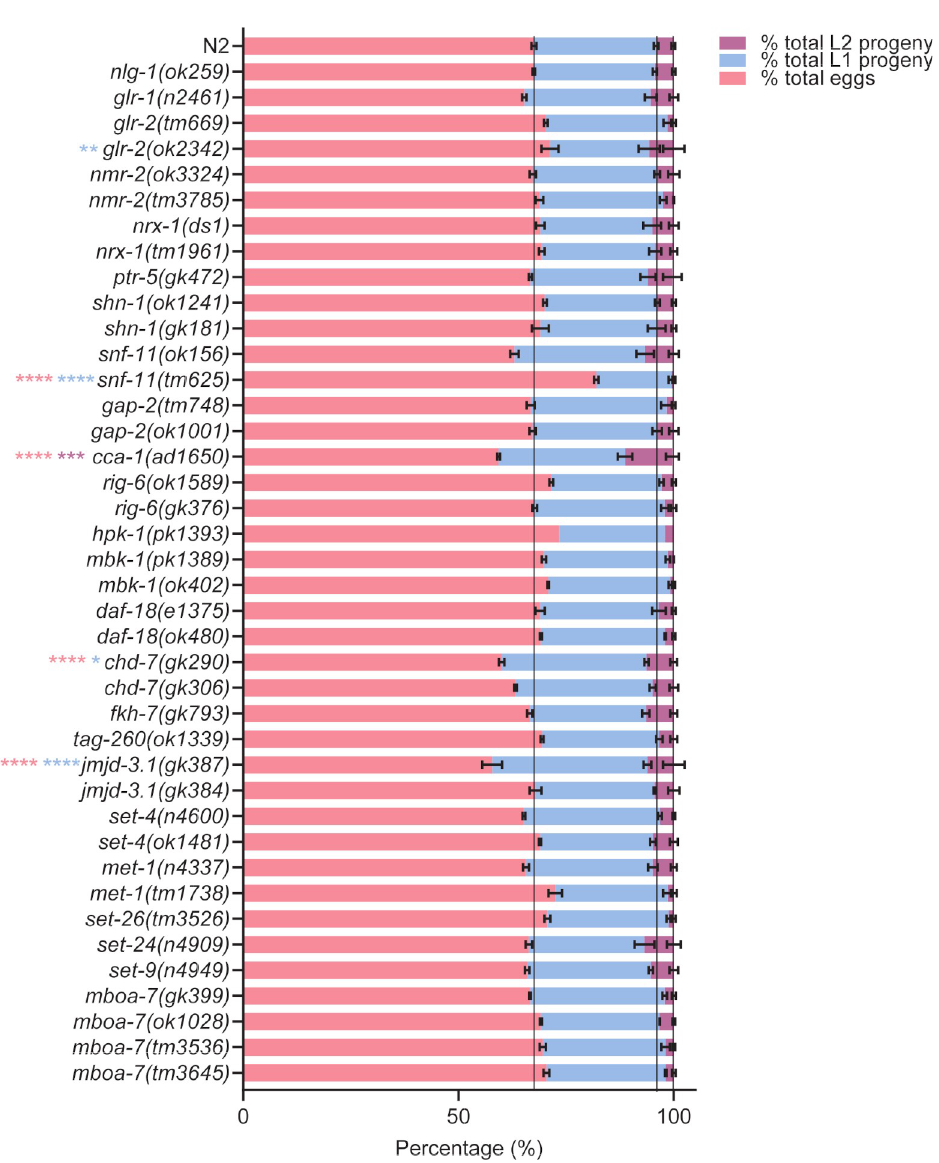
Fig 4. Percent total eggs and progeny produced by C . elegans mutants at 24 hours. After a food leaving assay from na ï ve food lawns occupied by 7 L4+1, the percent total offspring that were eggs, L1 and L2 progeny were quantified. N2 and nlg-1(ok259) n = 19. All other mutants n = 3–4, where n refers to the number of replicates of an individual experiment. Strains were screened in batches across different days. Each batch consisted of 4–6 mutant strains and a paired wild-type control. Data plotted includes all wild-type controls. The black lines indicate % total eggs, % total L1 progeny and % total L2 progeny for N2 control. Pink asterisks indicate statistical difference between mutant and N2 for % total eggs. Blue asterisks indicate statistical difference between mutant and N2 for % total L1 progeny. Purple asterisks indicate statistical difference between mutant and N2 for % total L2 progeny. All data shown as mean ± SEM. Statistical analysis performed using a two-way ANOVA and Tukey’s multiple comparison test; ns, p > 0.05; � , p < 0.05; �� , p � 0.01; ��� , p � 0.001; ���� , p � 0.0001. plotted the relationship between the number of progeny produced by a mutant and the food leaving behaviour and showed that the two were correlated (Fig 5). Interestingly, this applies to the nrx-1 and chd-7 mutants for which the two alleles tested resulted in distinct social phe- notypes (Fig 2). In each case the mutant that showed impaired social behaviour (Fig 2) also